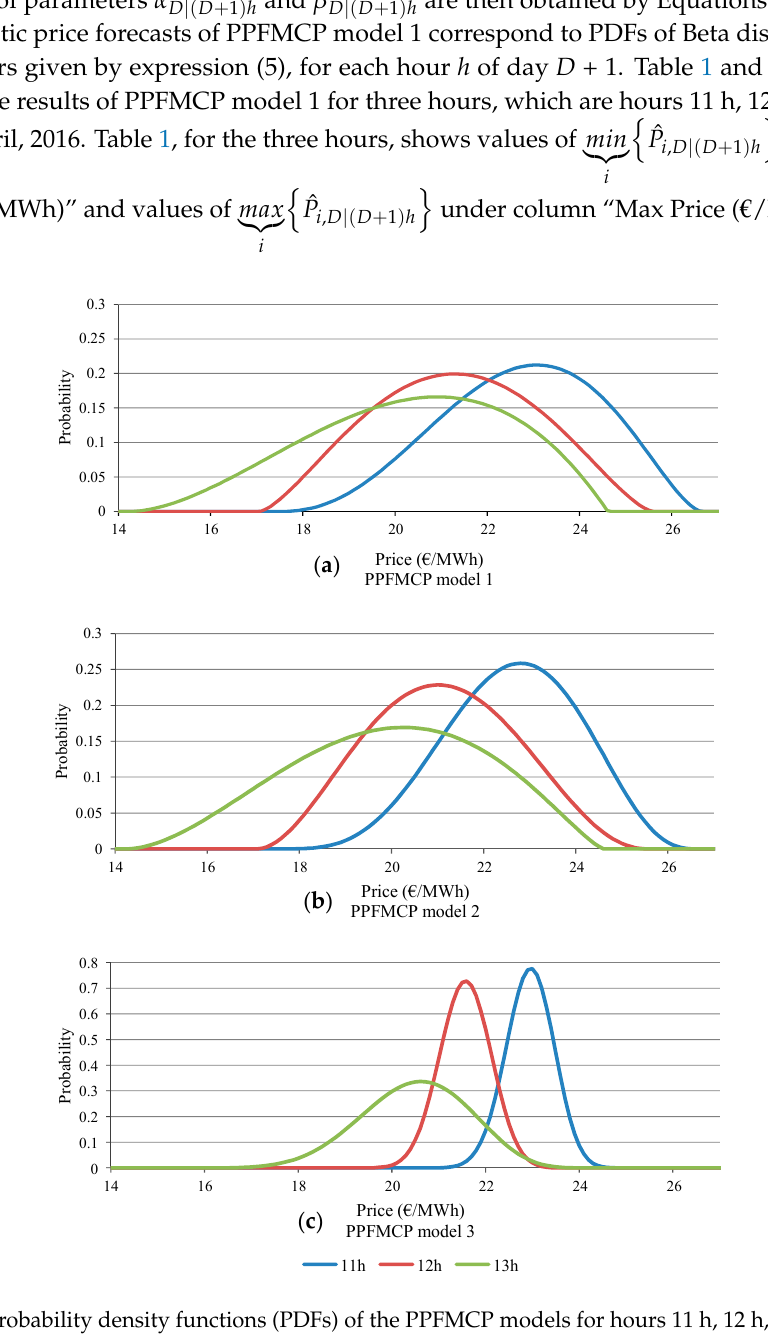
Table 1. Results of PPFMCP model 1.